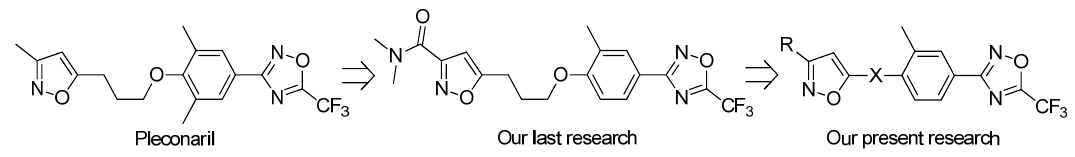
Figure 1. The Evolution of Pleconaril.